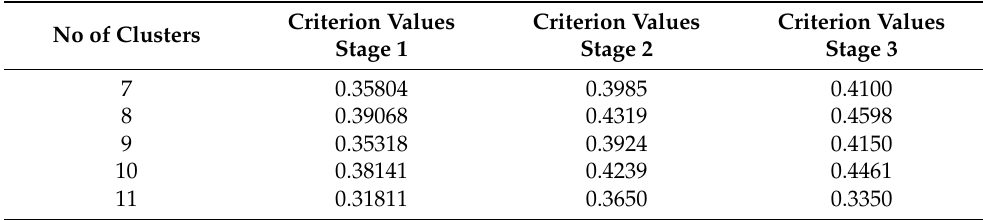
Table 2. Silhouette criteria clustering values stage 1 to stage 3 for a different number of clusters (testing 7–11